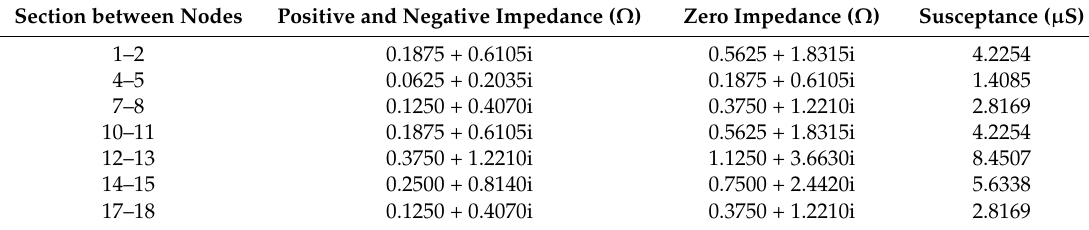
Table 1. IEEE 6-bus power system line parameters.